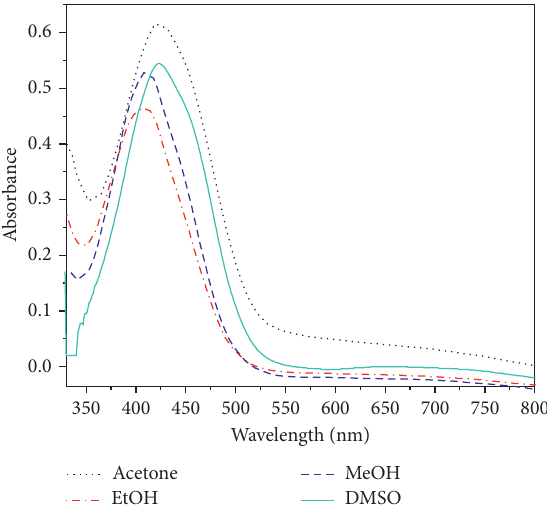
Figure 6: Electronic absorption spectra of 10 − 4 M CPAT dye in different solvents at ambient temperature.